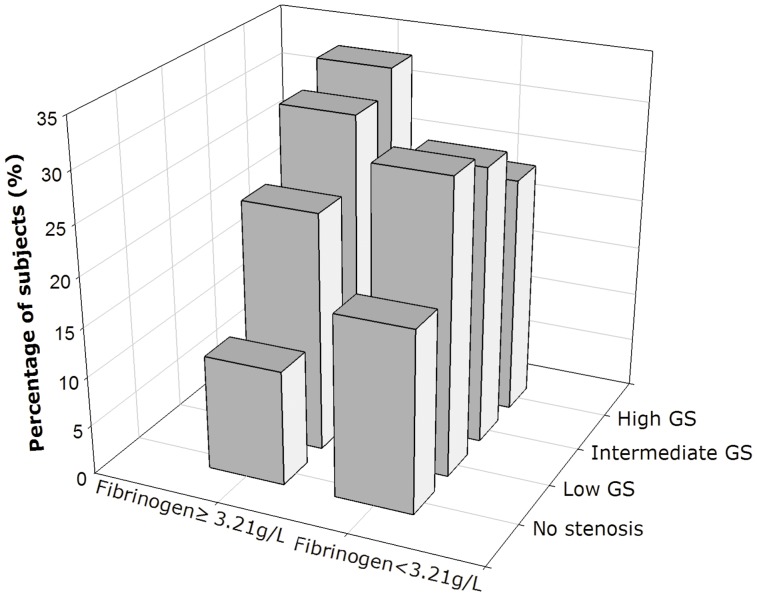
The distribution of subjects in high (≥3.21 g/L) or low (<3.21 g/L) fibrinogen groups according to the coronary stenosis and Gensini score.